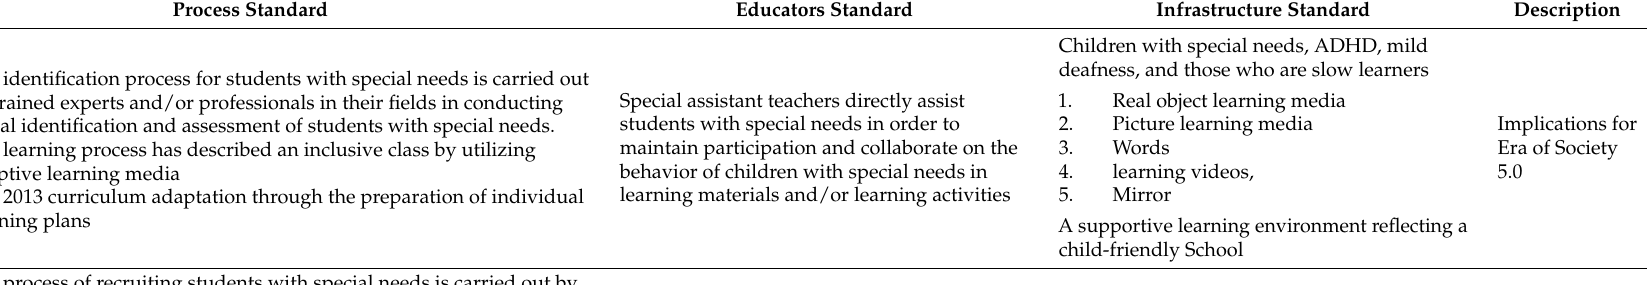
Table 1. Matrix of Research Activities for the Implementation of Inclusive Schools in South